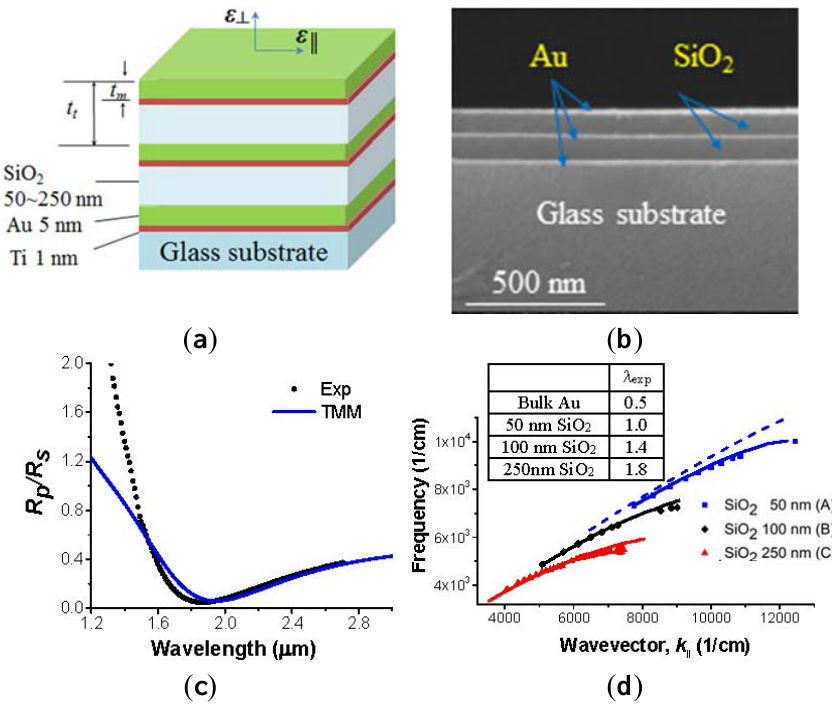
Figure 5. Schematic and SEM image of hyperbolic metamaterial (HMM) and the classic signatures for the identification of SPR mode of Hyperbolic metamaterial (2.5 pairs of Au/SiO 2 with Au 5 nm and SiO 2 100 nm thickness) at incidence angle of 45 degree. ( a ) HMM made of alternating layers of Ti-Au (1 nm thick Ti and 5 nm thick Au), and SiO 2 (50, 100 or 250 nm thickness); referred to sample A, B, and C, respectively. ( b ) Cross-sectional SEM image showing clear identification of 3 layers of Au (5 nm thick) and 2 layers of SiO 2 films (100 nm thick). ( c ) The presence of a reflectivity minimum at the SPP resonance total internal reflection (TIR) configuration. The results obtained from the transfer matrix method (TMM) are a blue solid line. ( d ) Surface plasmon dispersion curves from three different metal filling factor samples (A, B, and C) of 0.118, 0.076, and 0.032 arising from a different SiO 2 thickness: 50 nm in blue, 100 nm in black, and 250 nm in red, respectively. Experimental data from samples A, B, and C are indicated by symbols of squares (blue online), diamonds (black online), and triangles (red online). Dispersion calculation using TMM is solid. The free space light line is indicated by a light dotted